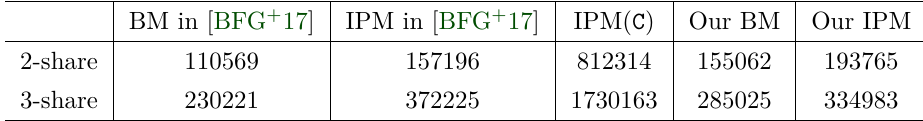
Table 4: Performance comparison by clock cycles for